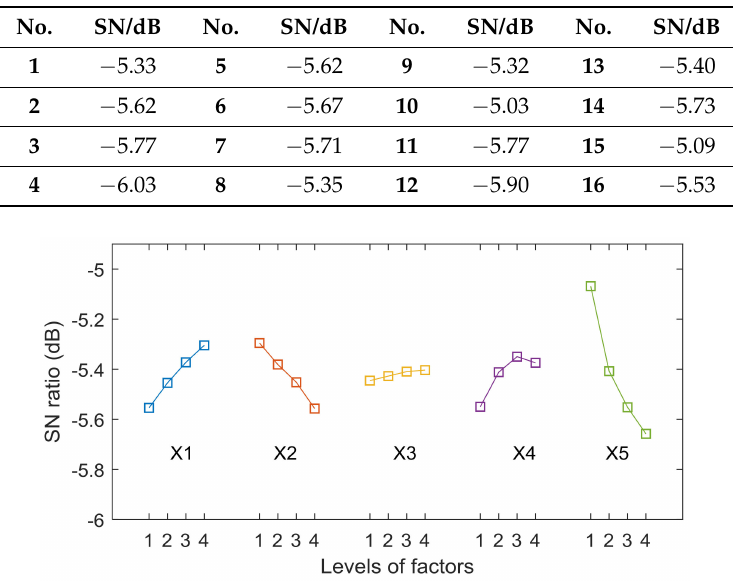
Figure 9. S/N ratios for each level of all